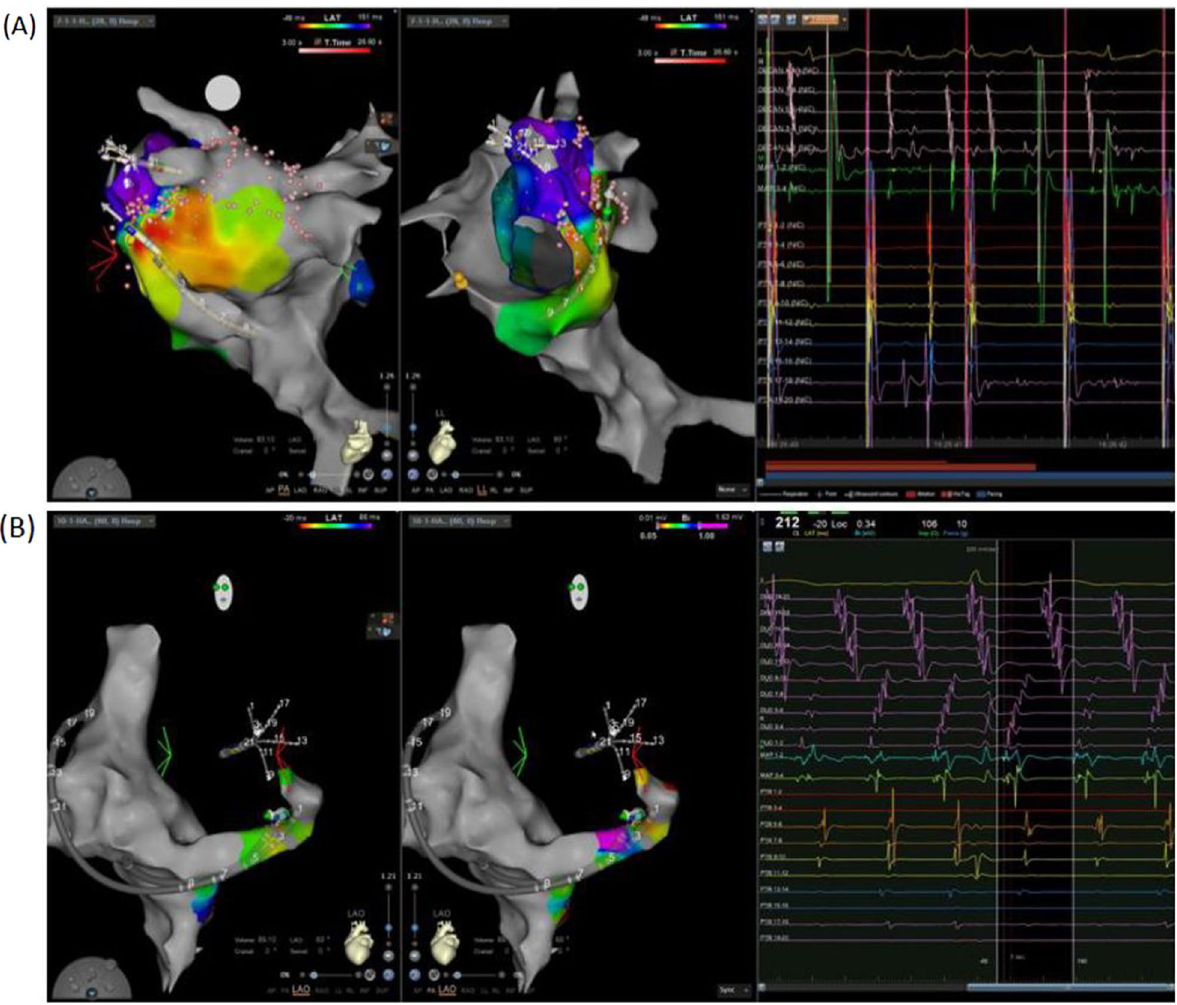
Fig. 3. 3D electro‑anatomical map showing the ablation inside of the coronary sinus. A Epicardial ablation inside the CS was performed for CS isolation. B Atrial tachycardia originated from vein of Marshall was induced during rapid atrial pacing. Epicardial ablation inside of the coronary